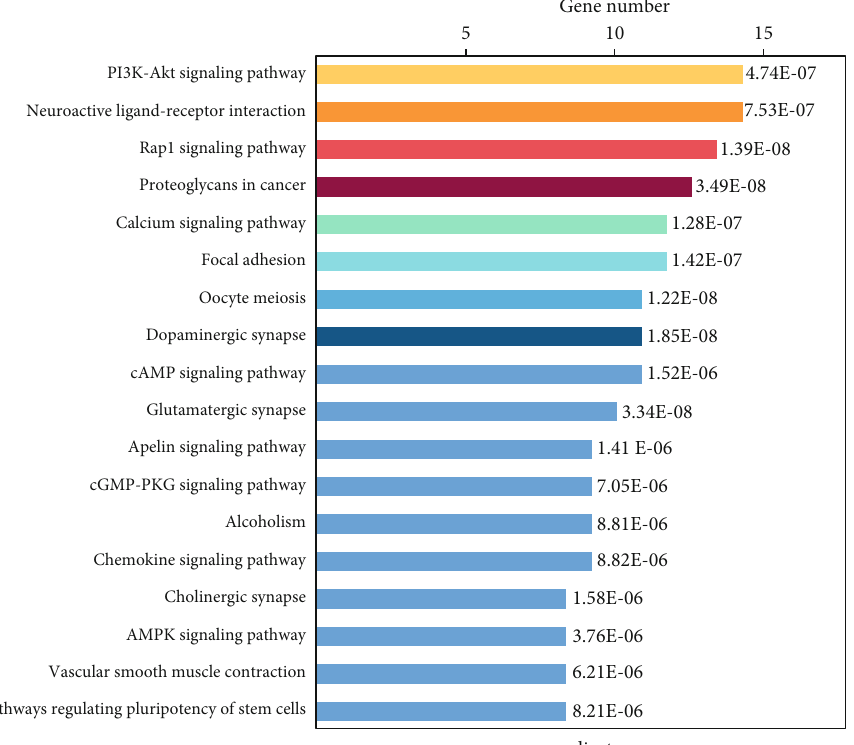
Figure 7: The list of top 18 enriched pathway analysis of